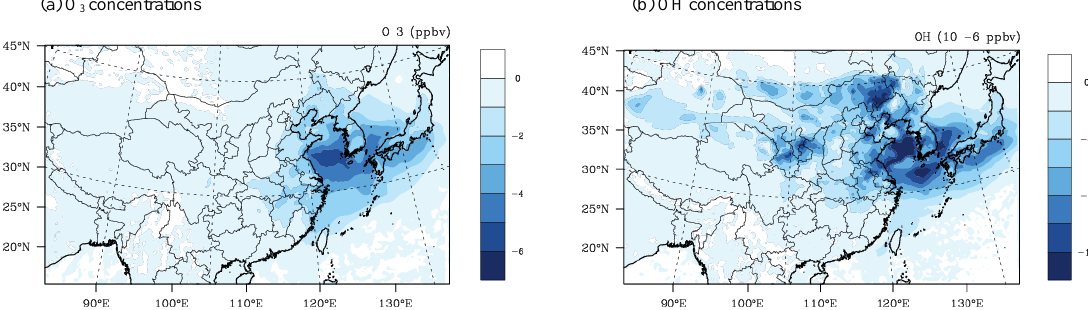
Fig.13. The average differences between the simulations in the surface layer by DUST_REVISED and DUST_OFF, April 28 to May 6. (a)O 3 concentrations;(b)OH concentrations